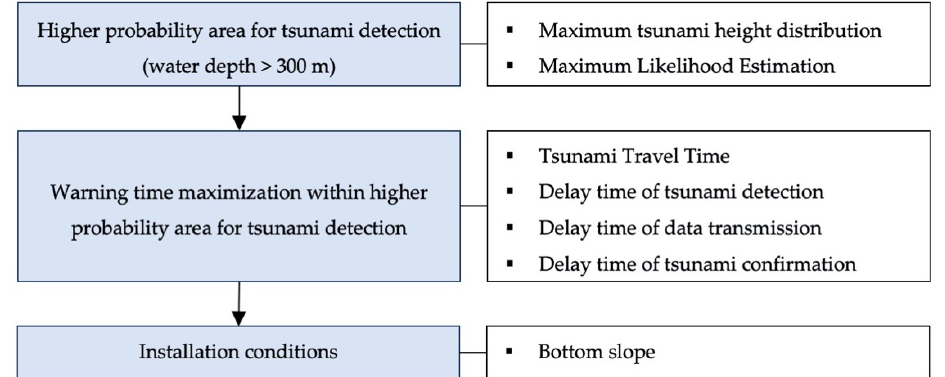
Figure 4. Flow chart (blue box) and considerations (white box) used for determining an optical deployment region for offshore tsunami observation instruments.